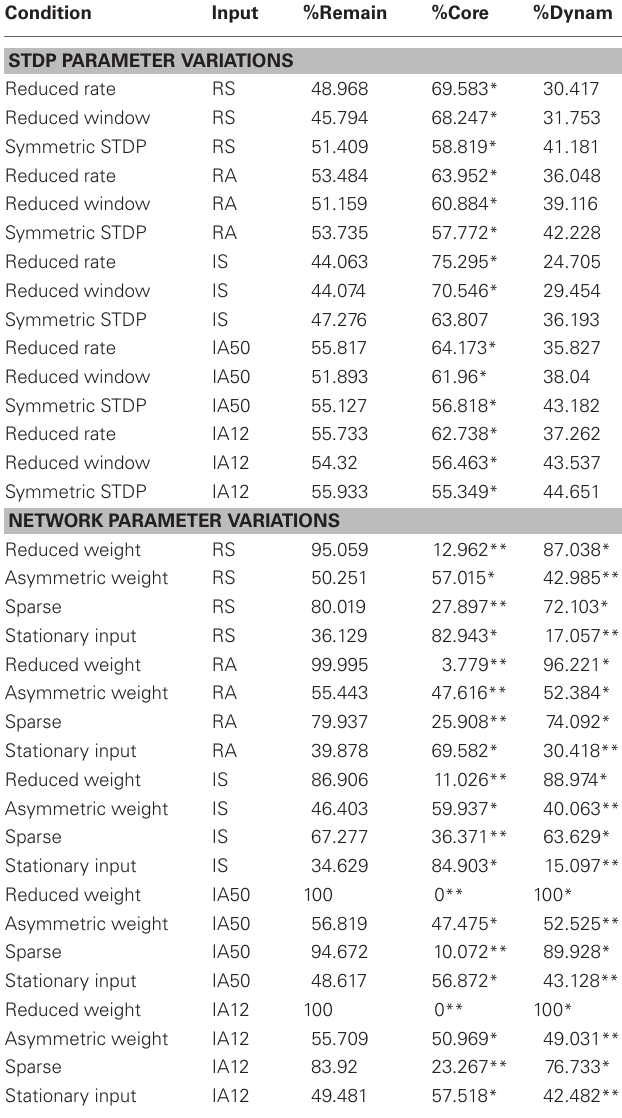
Table 4 | Core and dynamic triad characteristics for all parameter